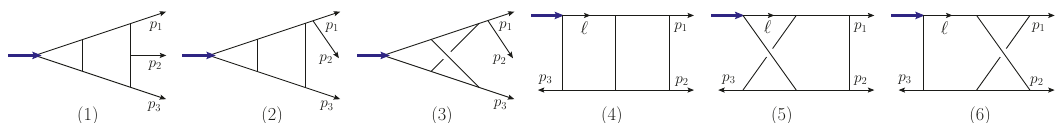
Figure 6. Trivalent topologies for the two-loop form factor of tr( φ 2 )